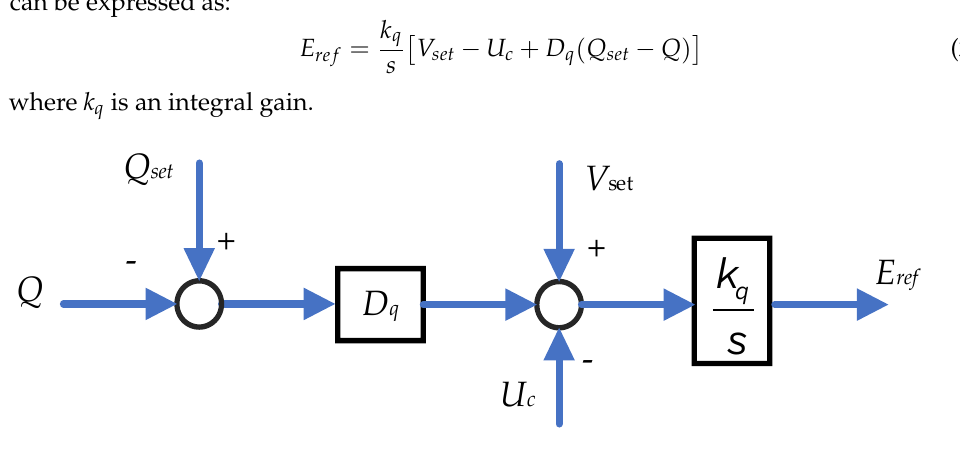
Figure 14. Droop-I control.